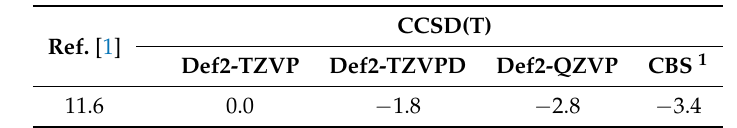
Table 1. Energy differences between isomers 1 and 2 in kcal/mol, calculated as ∆ E = E ( 1 ) − E ( 2 ) for consistency with Ref. [1]. Optimizations and ZPVE calculations were performed at the MBPT(2) level using the basis set